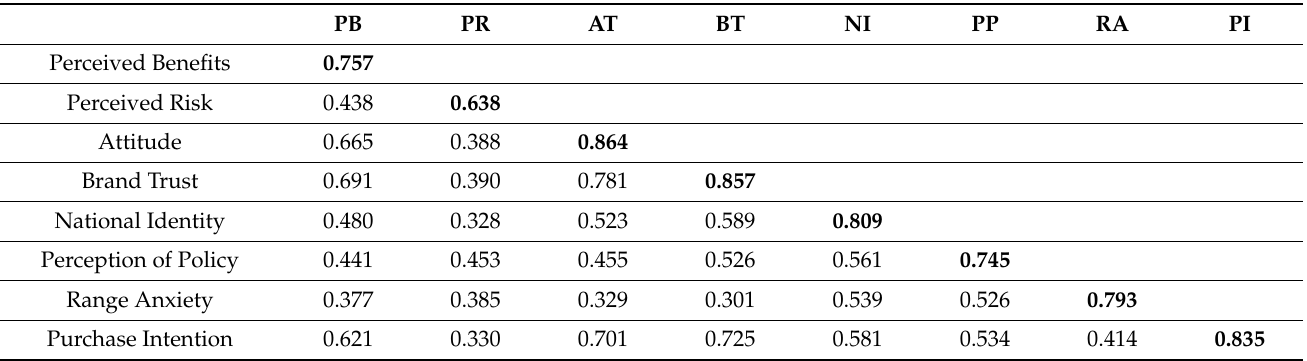
Table 6. Discriminant validity for the measurement model.